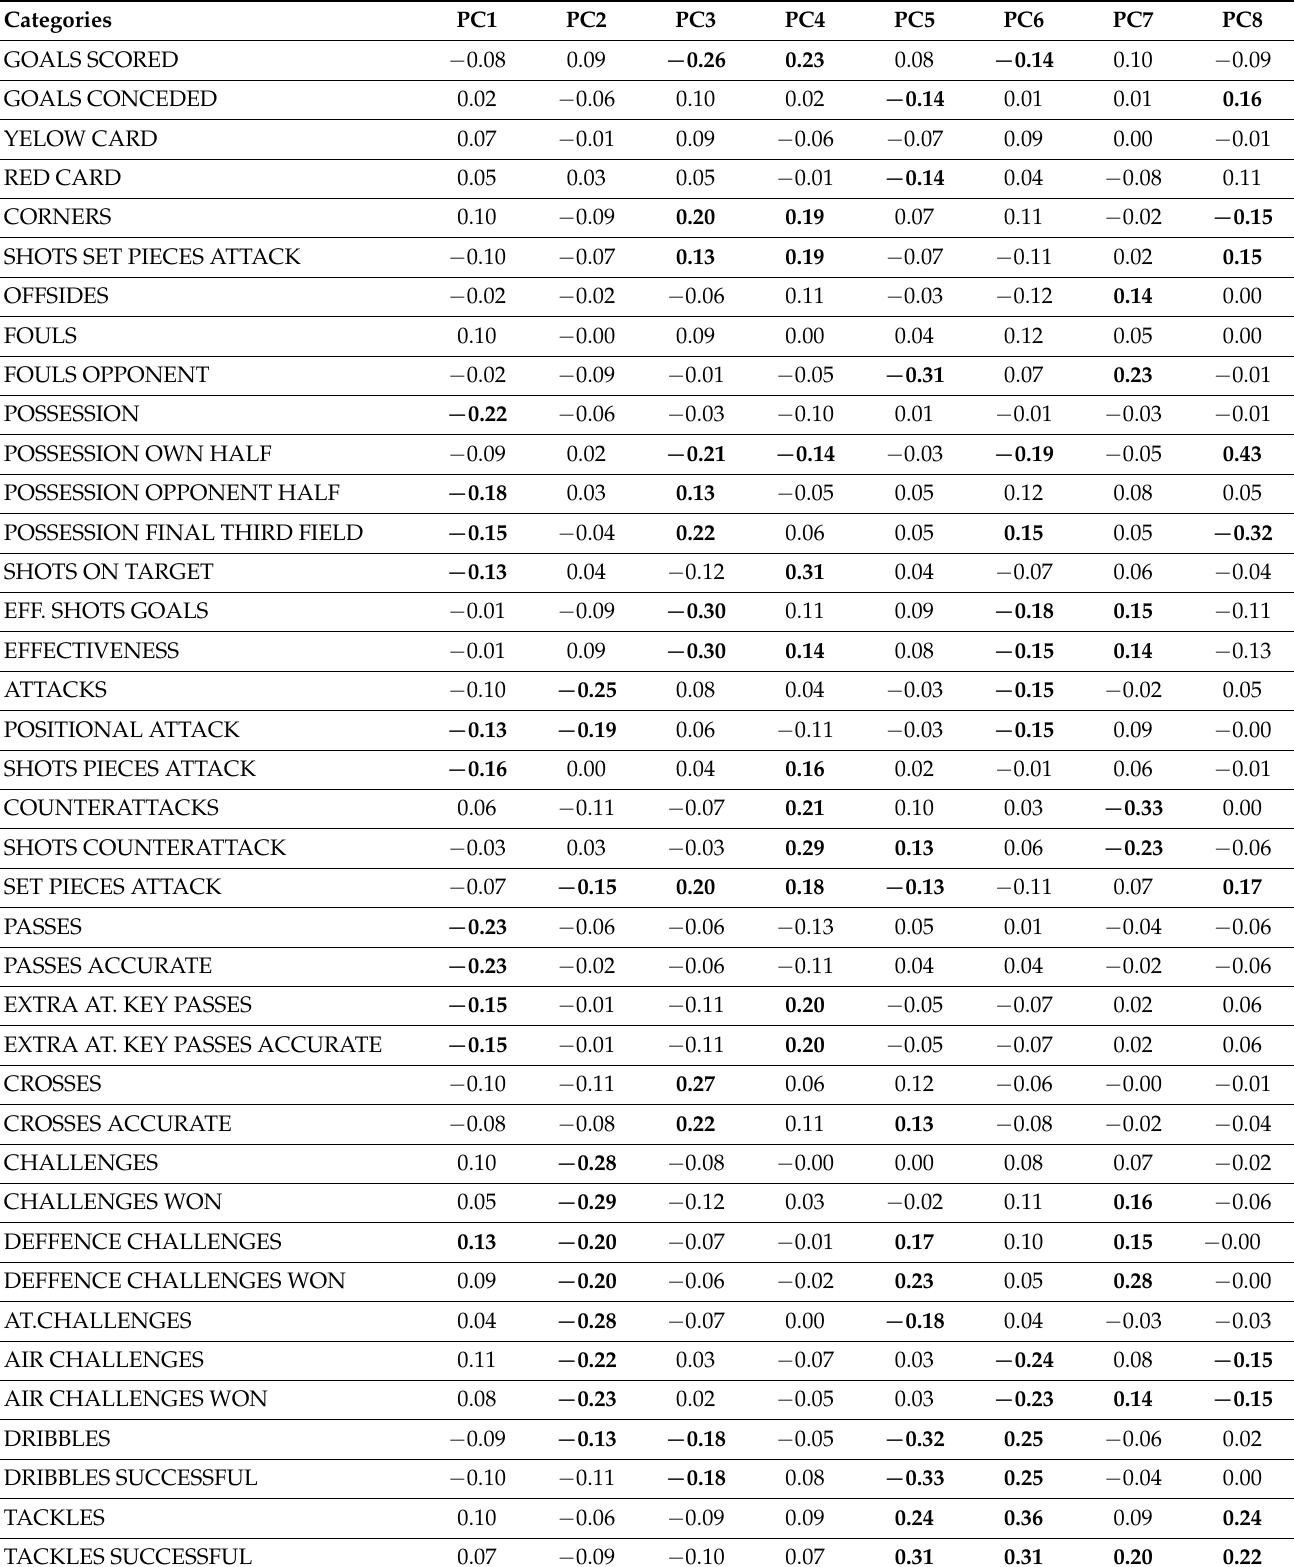
Table 3. PCA factorial matrix of best